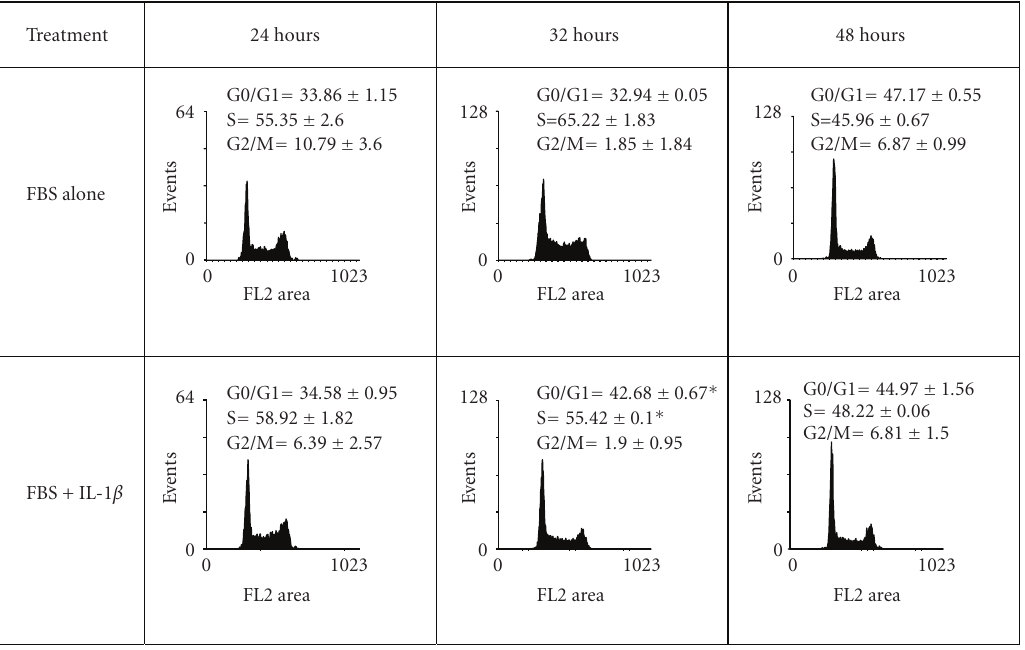
Table 1: IL-1 modulation of cell cycle progression. Synchronized JAR cells were cultured with or without IL-1 at concentration of 50ng/mL for 24, 32, and 48 hours. The cells were harvested and stained with propidium iodide. Percent cells (mean ± SEM) in each cycle phase were then analyzed in cells collected using flow cytometer. The asterisk ( ∗ , P < . 0001) represents significant di ff erence between antimalarial drug treatment and control groups as analyzed by T - test